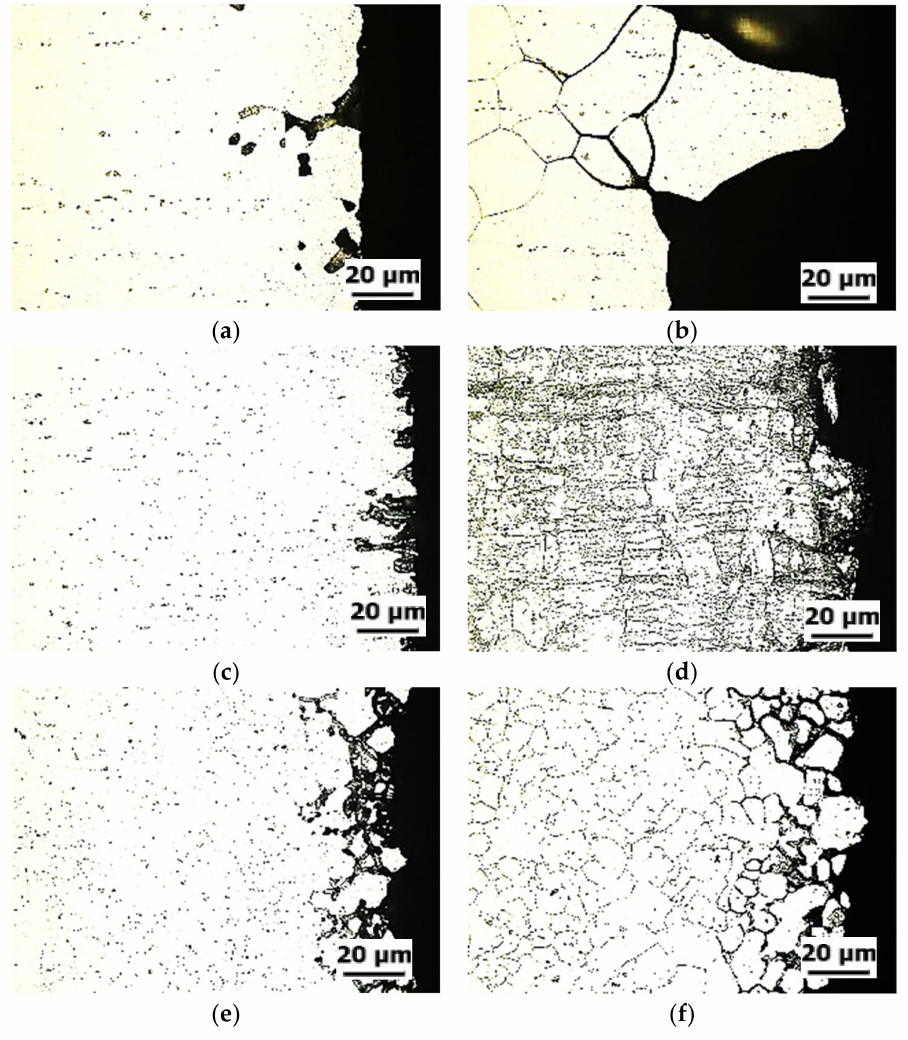
Figure 5. Microstructure of attacked surface by IGC ( a ) E, ( b ) ES, ( c ) CR, ( d ) CRS, ( e ) A, and ( f ) AS, etched by phosphoric acid for 25